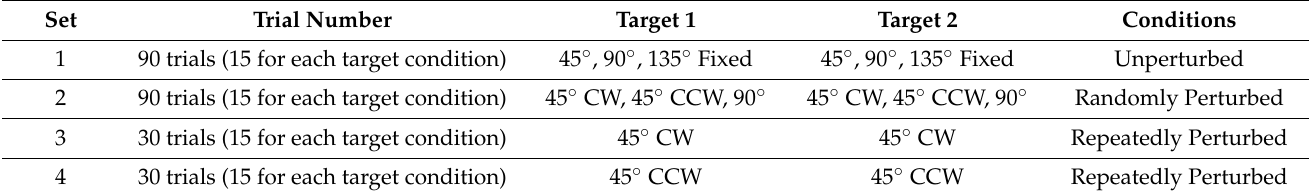
Table 1. Target orientation conditions in the perturbation